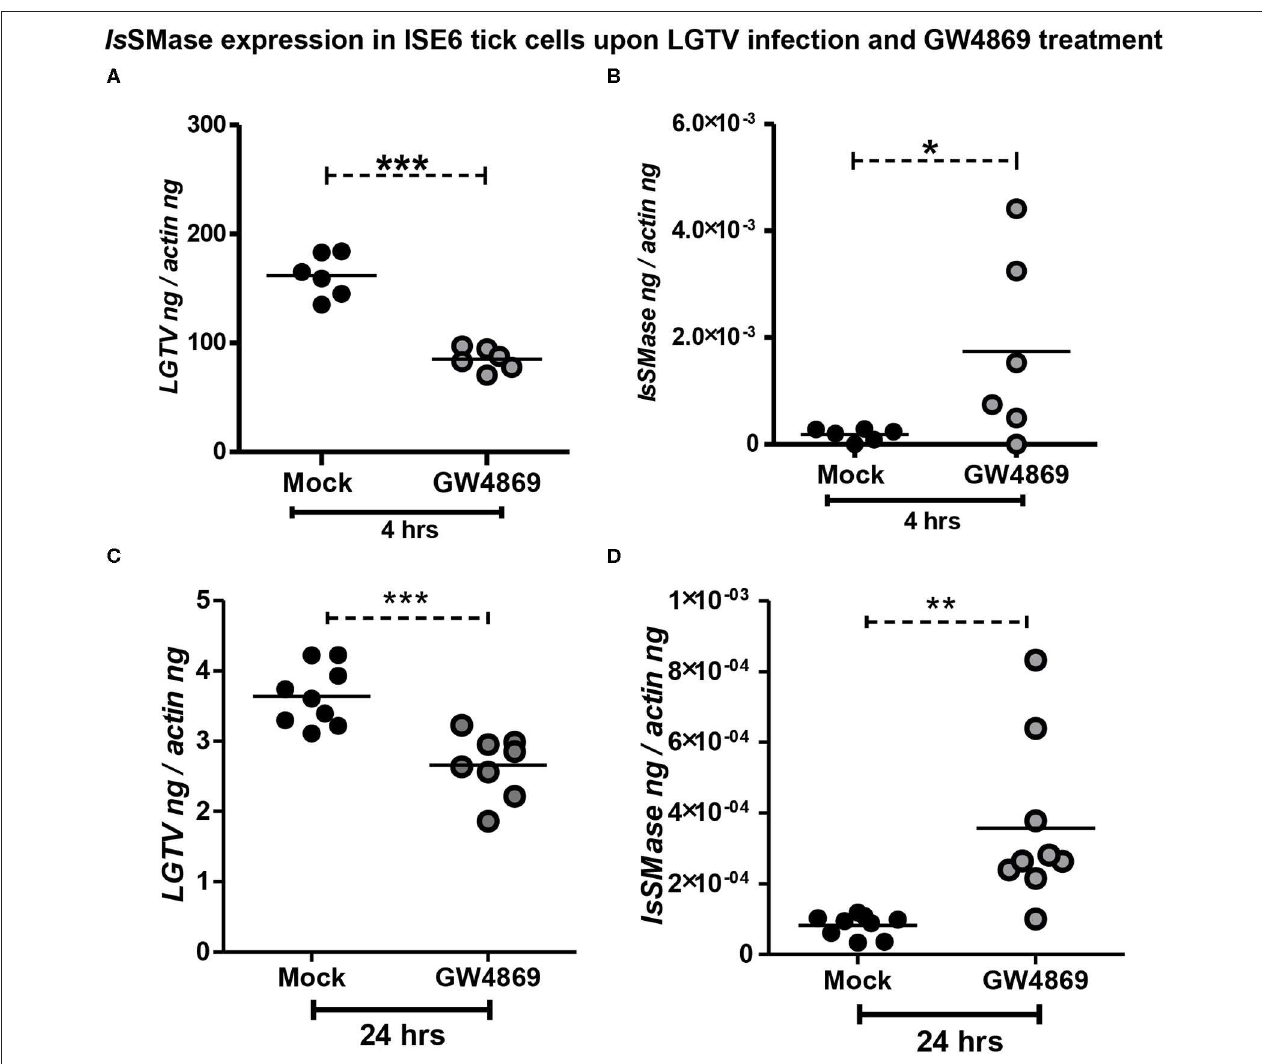
FIGURE 5 | GW4869 treatment restored the Is SMase expression by inhibiting LGTV loads in tick cells. (A) QRT-PCR analysis showing LGTV loads (A,C) or Is SMase mRNA levels (B,D) upon pre-treatment of ISE6 tick cells with GW4869 (1 µ M) for either 4h (A,B) or 24h (C,D) followed by LGTV infection (for 72h p.i.). Both mock and GW4869 inhibitor-treated groups were infected with 1 MOI of LGTV. Mock represents the group treated with vehicle DMSO. Each circle indicates sample generated from one culture well and analyzed as 6–10 replicates. Black circles represent the LGTV-infected mock group, whereas gray circles denote the LGTV-infected GW4869 inhibitor-treated group. LGTV loads or Is SMase mRNA levels were normalized to tick beta-actin levels. P -value determined by Student’s two-tailed t -test is shown. The asterisk indicates significance, and *, **, or *** denotes a P -value of less than 0.05, 0.01, and 0.001,